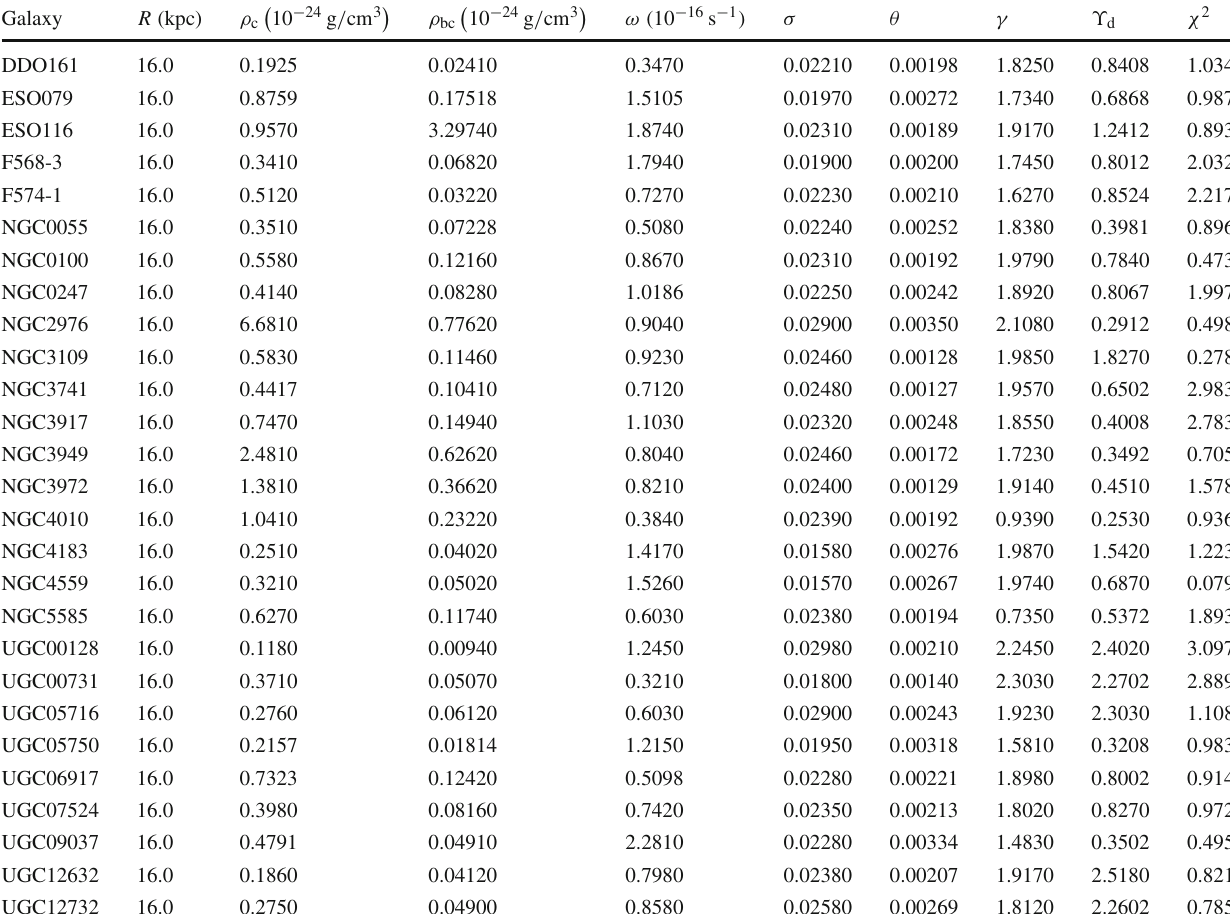
Table 3 Optimal fitting parameters for 27 bulgeless SPARC galaxies with constant static radius R